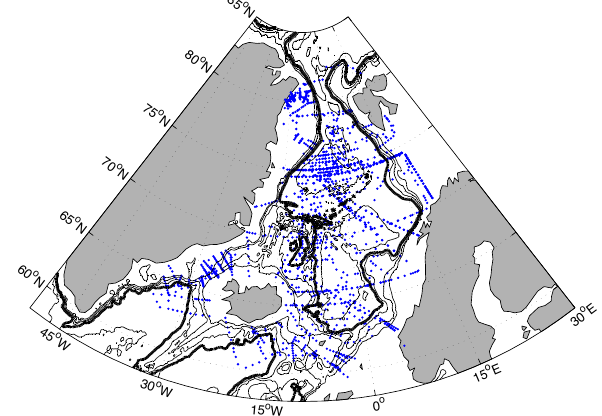
Figure 1. The Nordic Seas with oxygen sampling positions. Bathymetry has been drawn at 500, 1000, 1500, 1900, 3000 and 4000m, with the 1900m isobath in